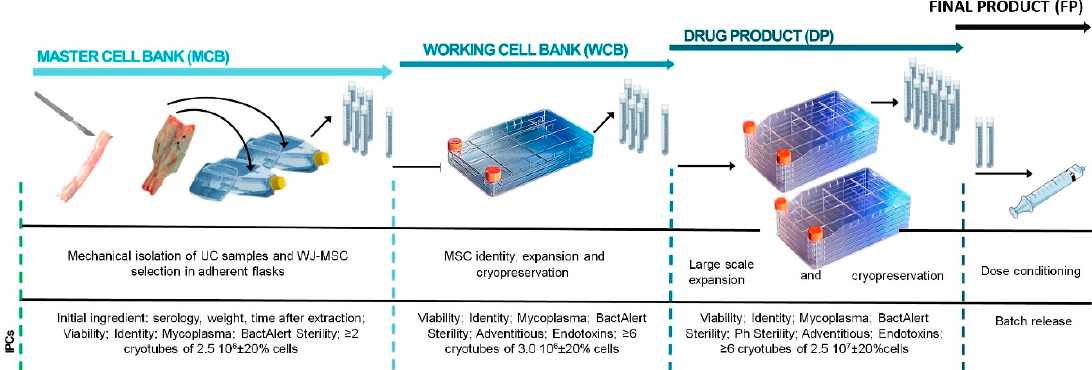
Figure 1. Schematic of bioprocess and established in-process controls (IPCs) for the follow up of the critical quality attributes for starting material and drug product. Although initial setup included an intermediate working cell bank, the competent regulatory authority allowed the possibility to expand drug product (DP) directly from the master cell bank (MCB). UC: Umbilical cord; WJ-MSC: Wharton jelly–mesenchymal stromal cells; IPC: In-process controls; Ph: Pharmacopea.